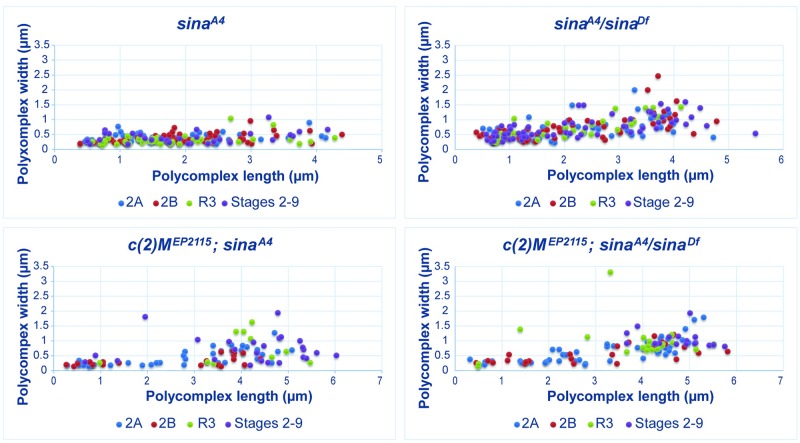
The length and width of polycomplexes in sina mutants.The measurements of the length and width of polycomplexes from sinaA4, sinaA4/sinaDf, c(2)MEP2115; sinaA4, and c(2)MEP2115; sinaA4/sinaDf females. Colored dots show the measurements of the polycomplexes at early pachytene (region 2A) in blue, early/mid-pachytene (region 2B) in red, mid-pachytene (region 3) in green, and mid-prophase (stages 2–9) in purple. See S3 Fig for graphs separated by stage. Measurements are in microns.